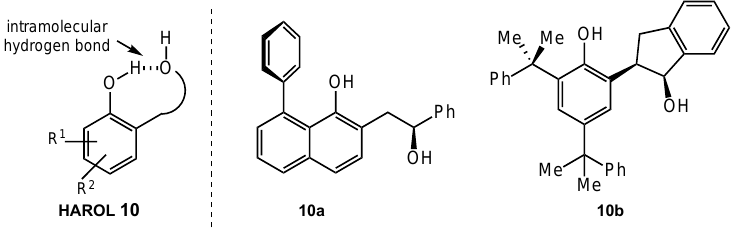
Scheme 48. Structures of hydroxyarylalcohols (HAROLs).